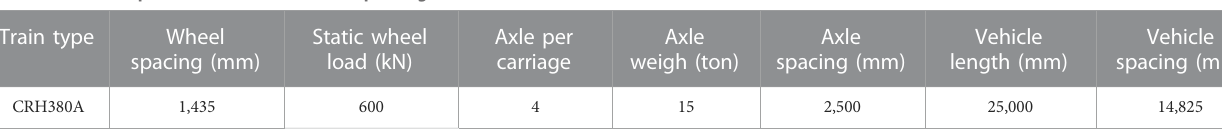
TABLE 3 Technical parameters of the CRH380A passenger train.